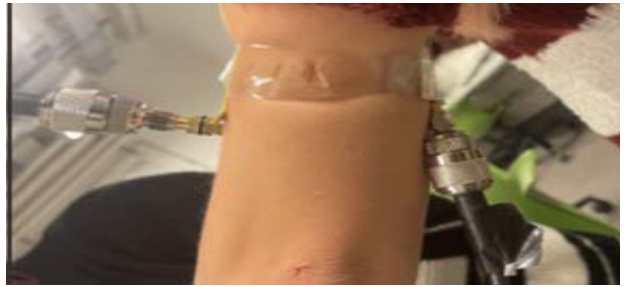
Figure 11. The fabricated pair of antennas are placed on a real human arm of radius 45 mm to examine the transmission coefficient.